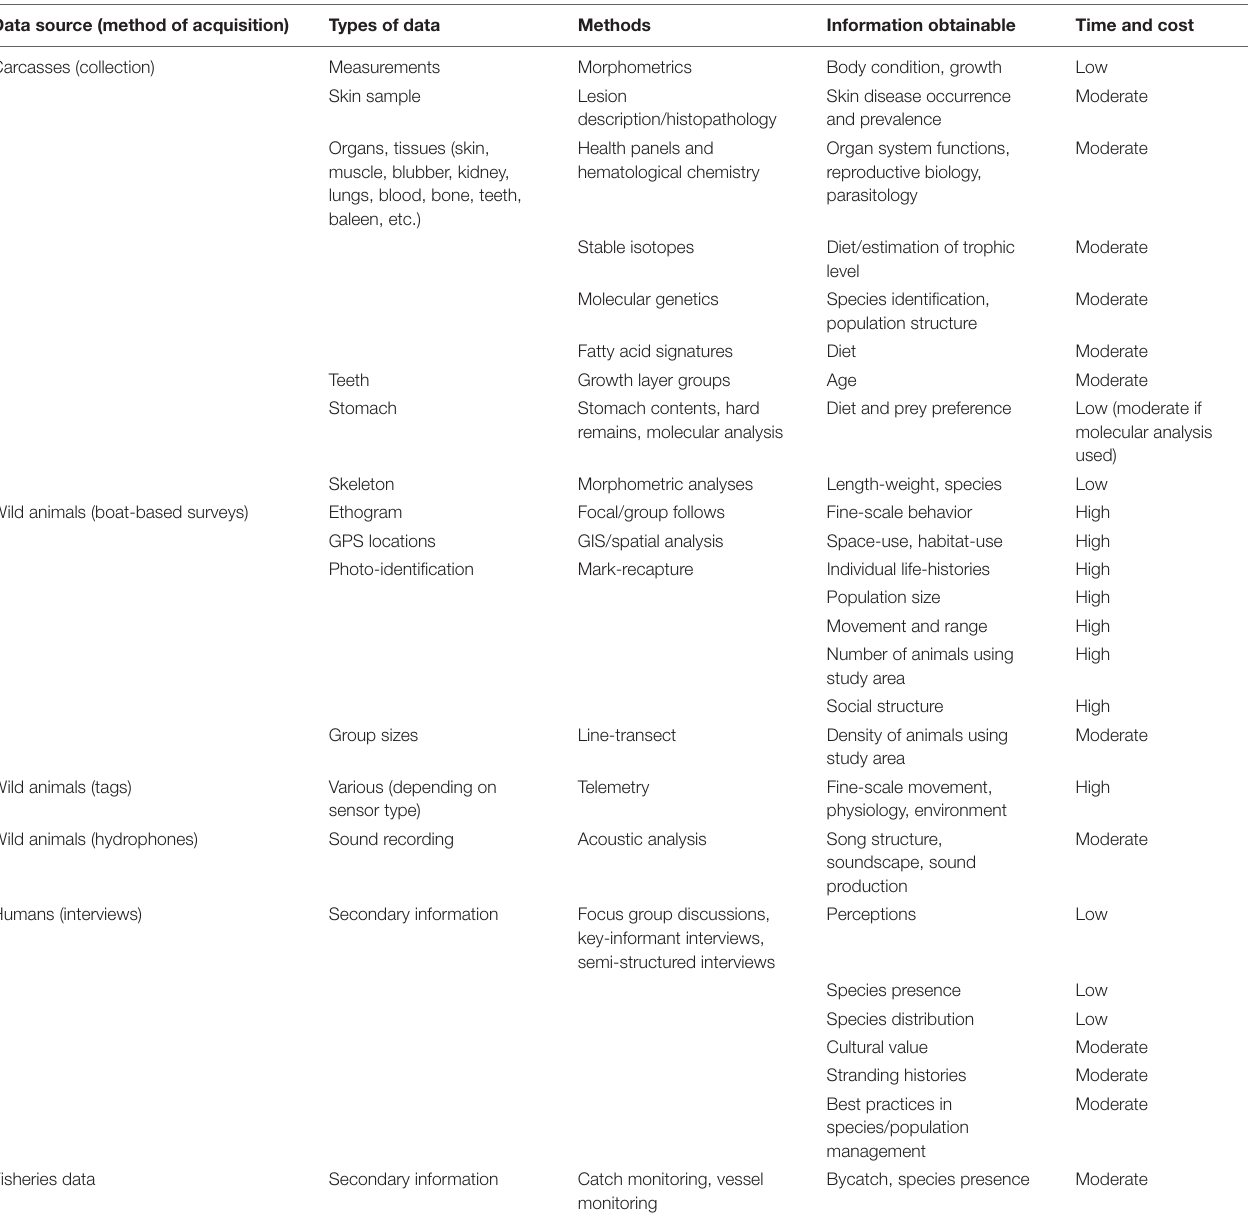
TABLE 4 | Summary of marine mammal research methods that are underutilized and/or recommended for future